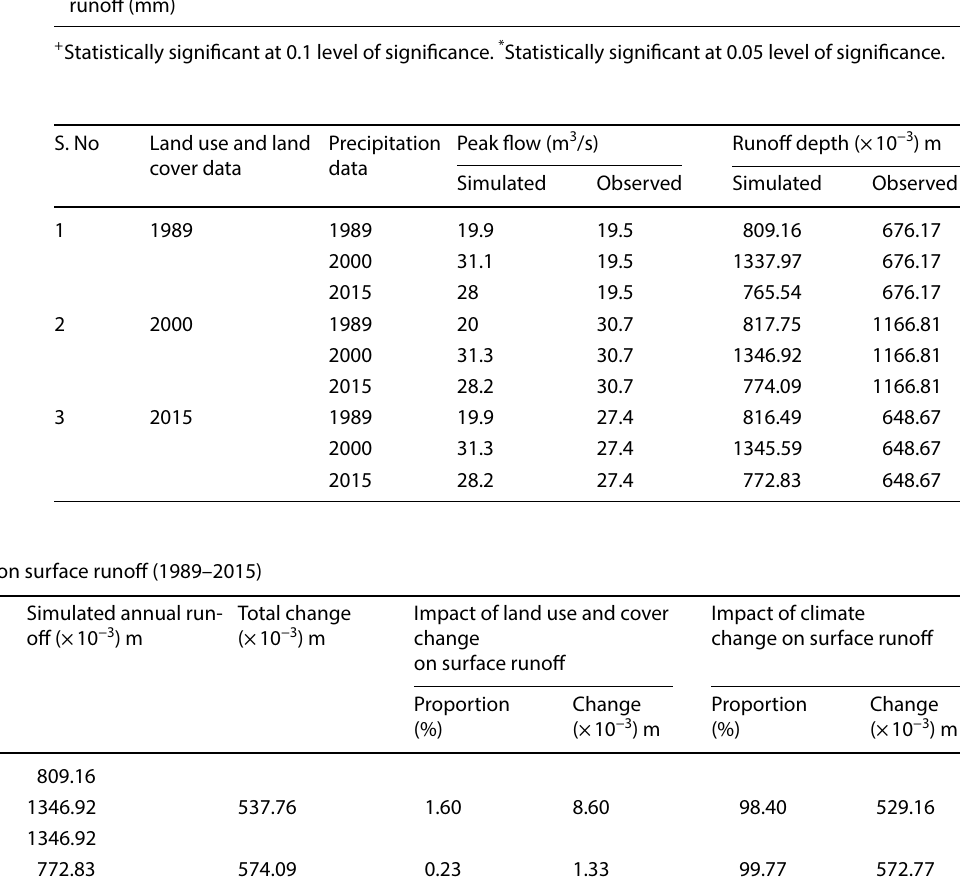
Table 11 Trend statistics of mean precipitation and temperature in Hayk Lake basin